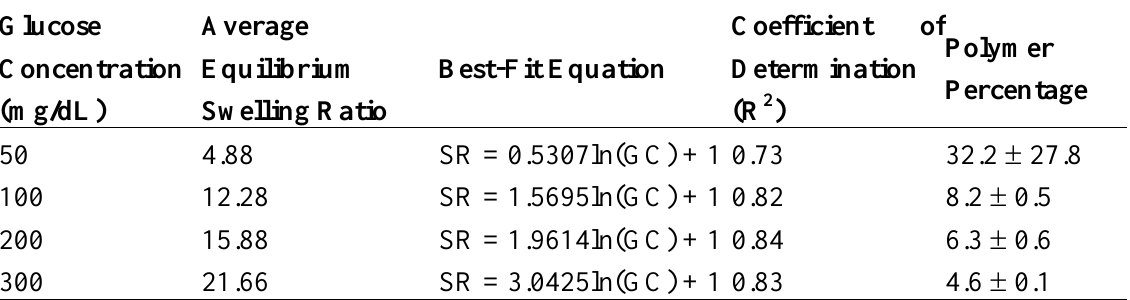
Table 1. Polymer percentage and best-fit trend lines for the swelling ratio versus time for hydrogels exposed to 50, 100, 200, and 300 mg/dL glucose